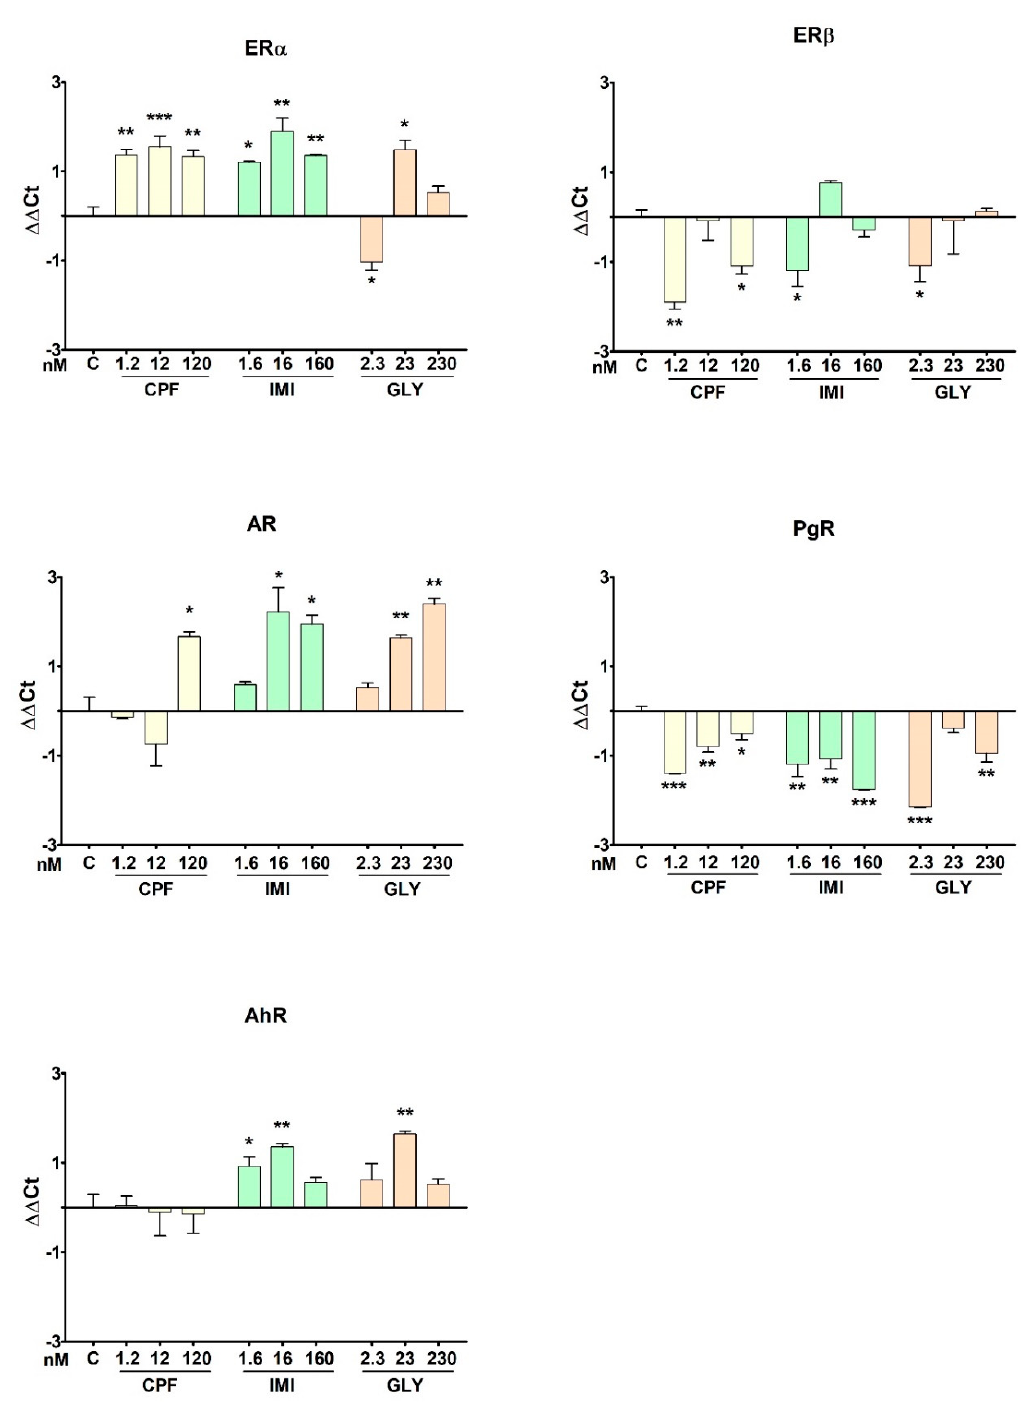
Figure 7. Gene expression levels of a panel of nuclear receptors assessed in MCF-7 cells following treatment with CPF, IMI and GLY for 72 h. Data are mean ∆∆ Ct values ± SEM of three independent experiments, with control cells as calibrators and the geometric mean of GAPDH and ACTB as a reference. Asterisks indicate statistically significant differences with respect to control cells: * p < 0.05; ** p < 0.01; *** p < 0.001.